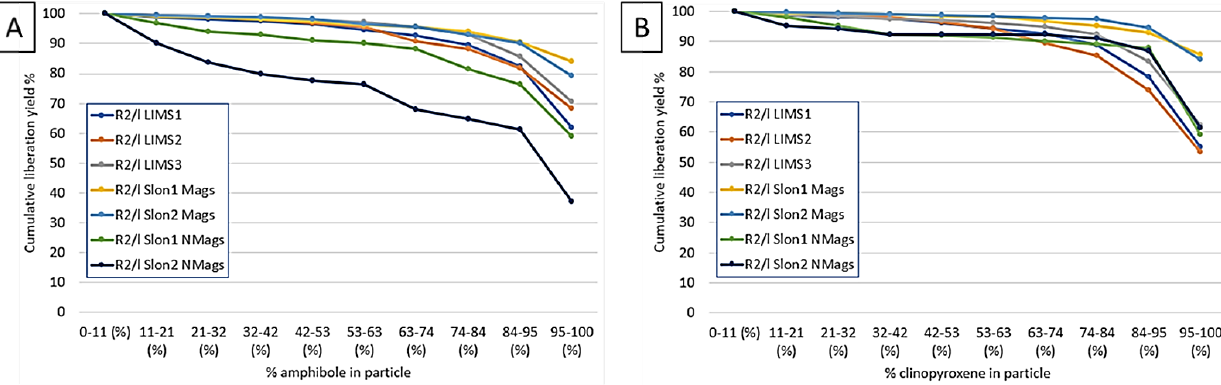
Figure 9. Cumulative liberation yields (%) for ( A ) amphibole and ( B ) clinopyroxene in R2/l magnetic LIMS and SLon concentrates and corresponding tailings.